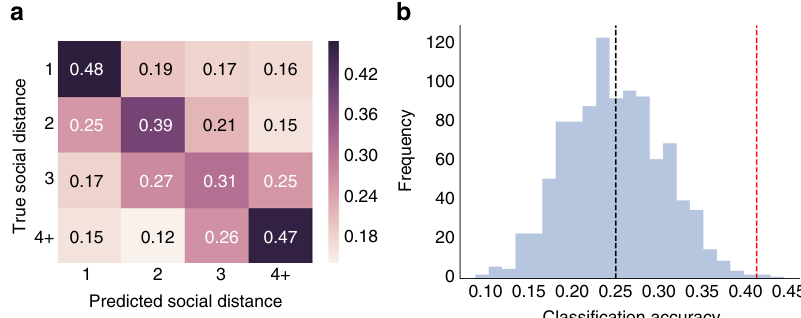
Fig. 8 Predicting social distance based on inter-subject neural similarities. a Confusion matrix summarizing cross-validated prediction accuracy of four-way classi fi ers trained to predict the geodesic distance between members of dyads in their social network based on patterns of neural similarity, averaged across data folds (see Methods for further details). Numbers and cell colors indicate how often the classi fi er predicted that dyads belonged to each social distance category (chance = 0.25). b Permutation testing was used to compare the overall cross-validated prediction accuracy to random chance. The distribution of accuracies achieved by repeating the classi fi cation analyses after randomly shuf fl ing the data category labels in the training folds 1000 times is shown in blue; the black dashed line depicts the average level of accuracy achieved in the randomly permuted data. The red dashed line indicates the actual overall cross-validated classi fi cation accuracy, which signi fi cantly exceeded chance ( p =